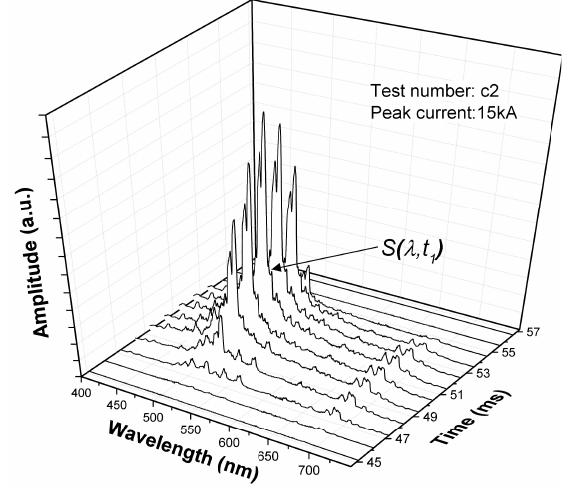
Figure 5. Contact surface images for different peak arc currents. ( a ) 5 kA, first test a1; ( b ) 25 kA, first test e1; and ( c ) 40 kA, fifth test h5.